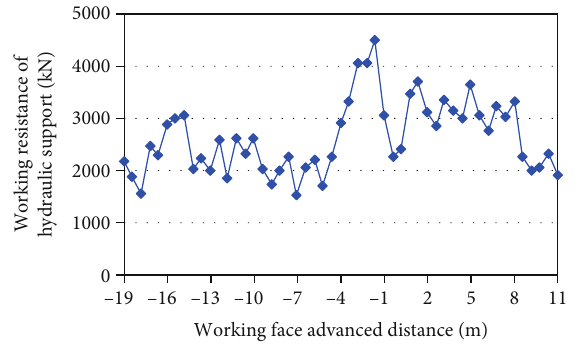
Figure 17: Average load curve of the support working through abandoned